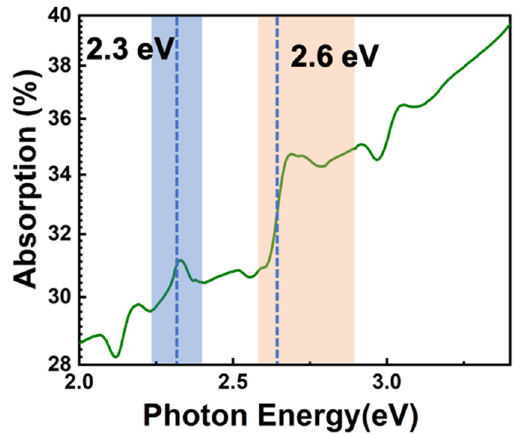
Figure 3. Absorption spectrum of perovskite embedding in mesopores as a function of conversion of photon energy. Working bands were labeled at 2.3 and 2.6 eV, respectively.